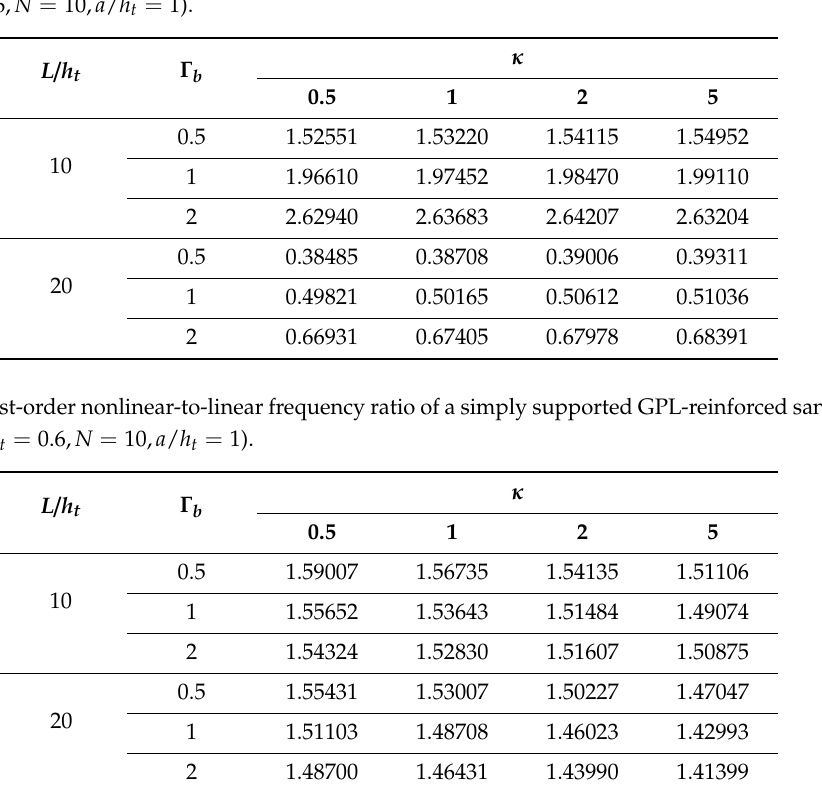
Table 4. First-order nonlinear frequency of a simply supported GPL-reinforced sandwich beam